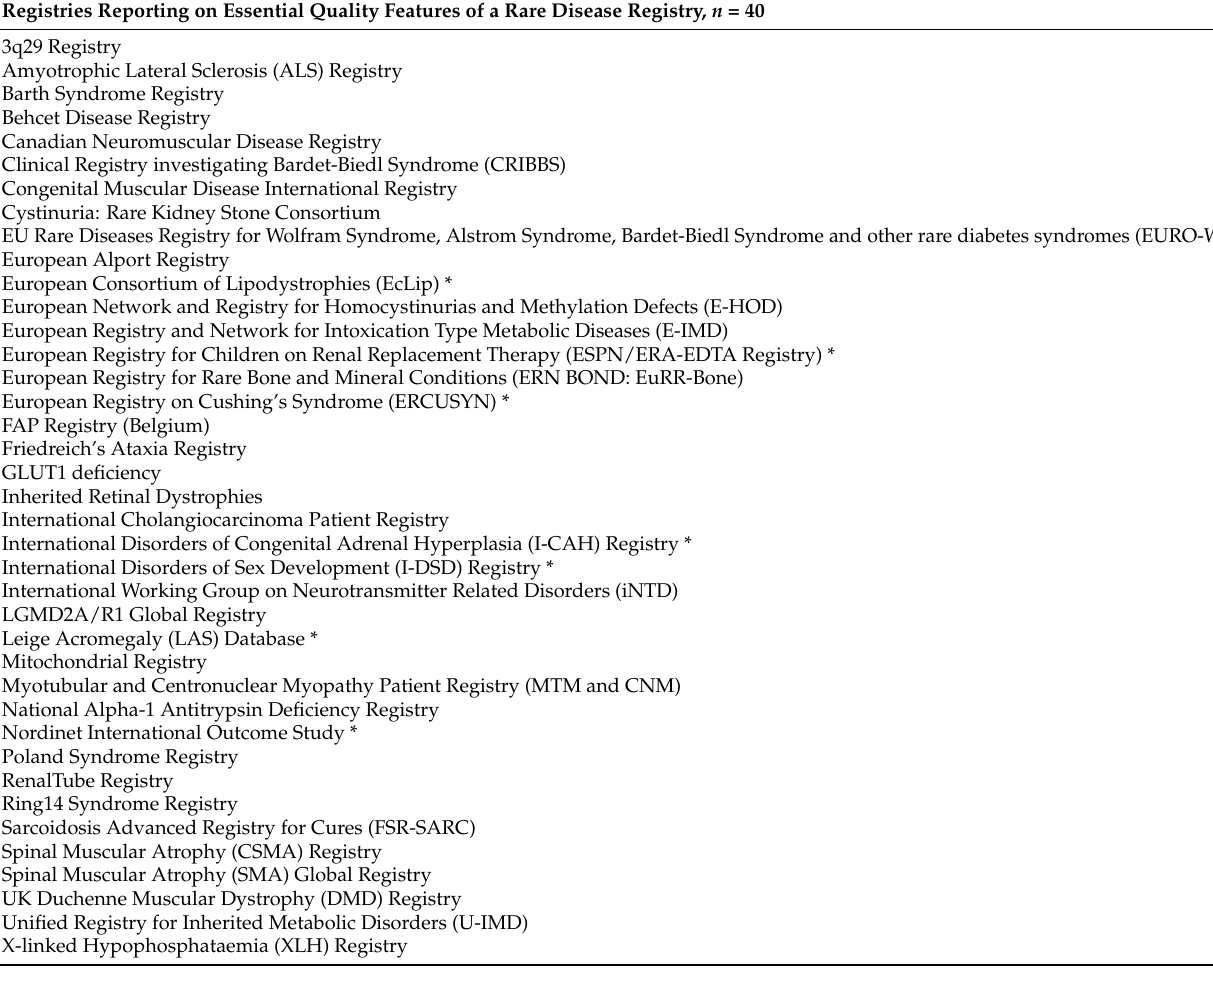
Table 2. Rare disease registries represented by survey